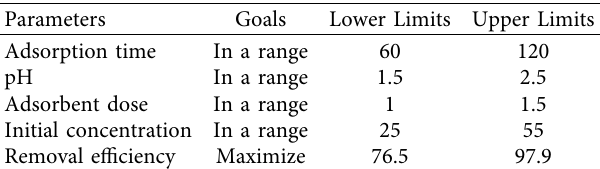
Table 6: Working conditions of parameters and response for